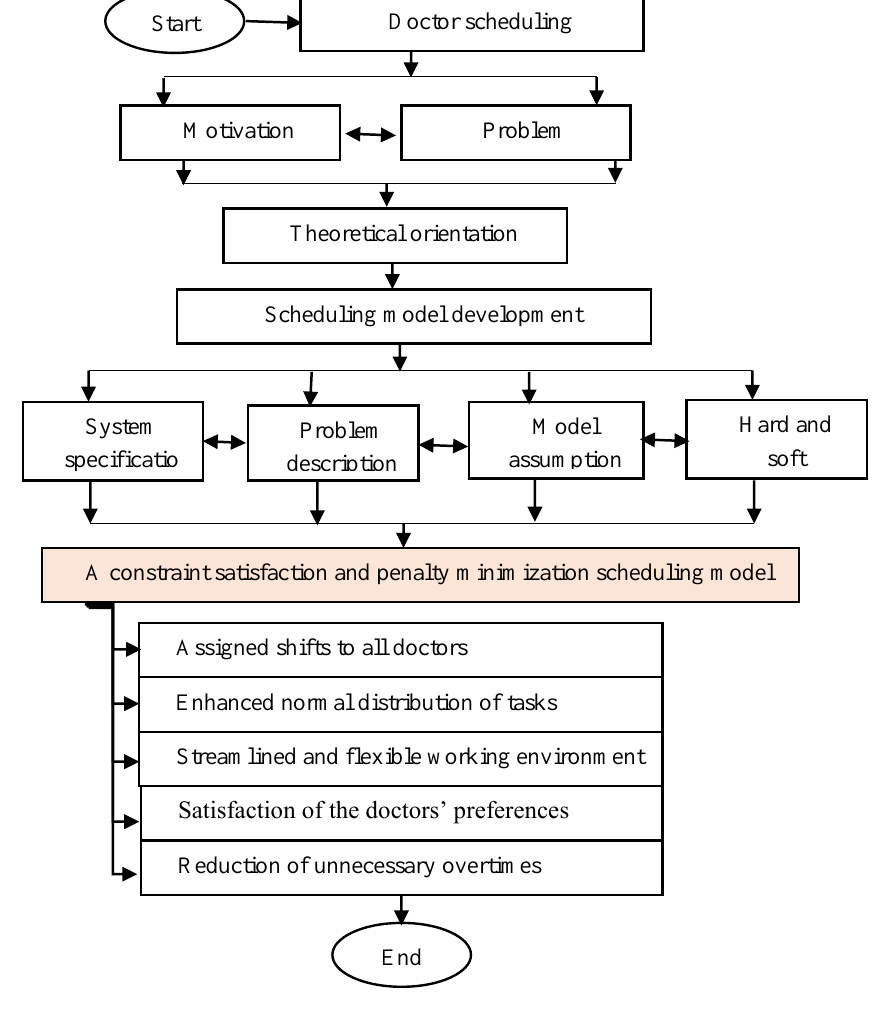
Figure 10. Enhanced Contributions through the